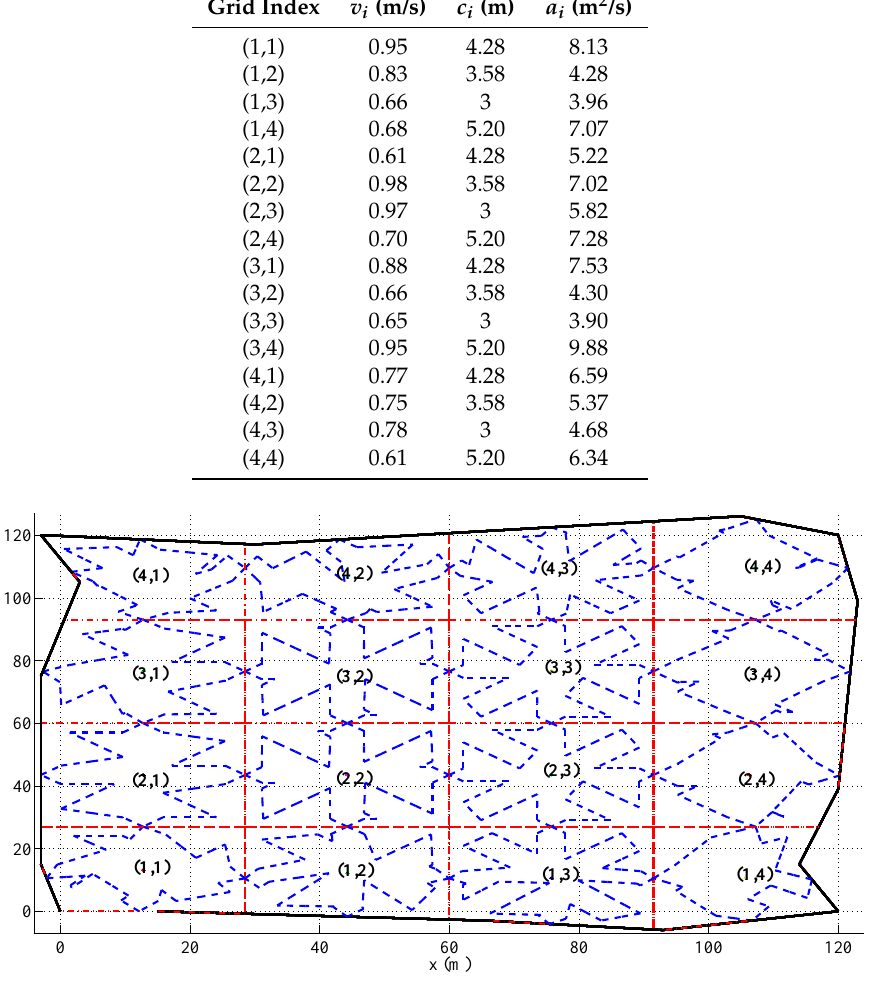
Figure 8. Initial area division considered during the simulations. The solid black lines define the irregular area to monitor. The dashed black lines determine the initial sub-areas assigned to the UAVs and the dashed blue lines their initial coverage paths generated using the path planning method proposed in Acevedo et al.